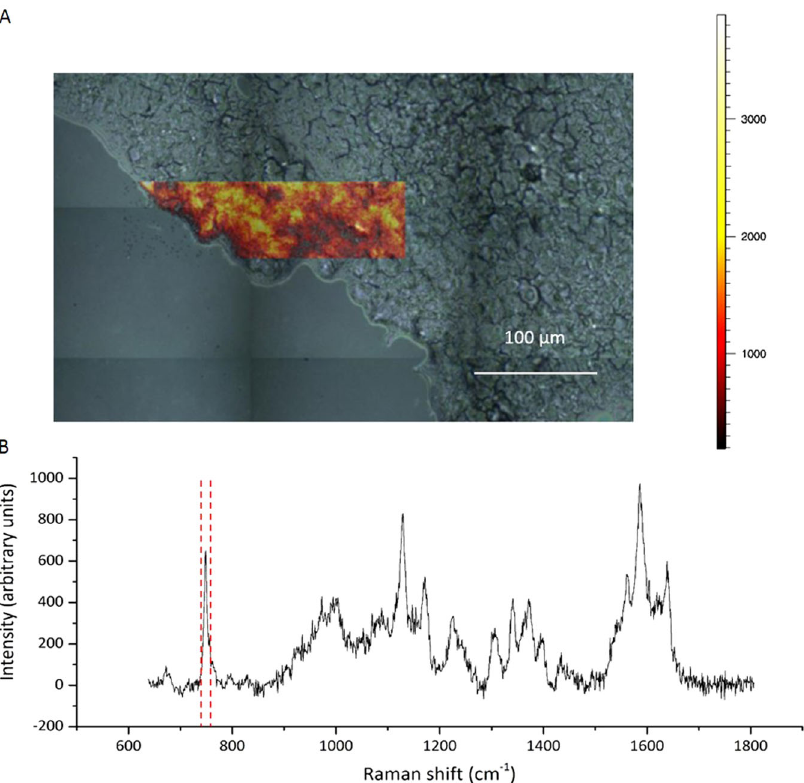
Fig. 3 a False colour map of peak due to ring breathing (associated with cytochrome, signal integrated between 740 – 760 cm − 1 ) in cryosection of murine liver tissue. Regions of low peak signal intensity are marked in red , while regions of high intensity are marked in yellow . Raman spectra were acquired with a 532 nm laser at 6 mW power, 3 s exposure and 1 μ m resolution using a 50× air objective. False colour scale bar of signal-to-baseline intensity (arbitrary units) is shown to the right of the map. b Example Raman spectrum from the acquired